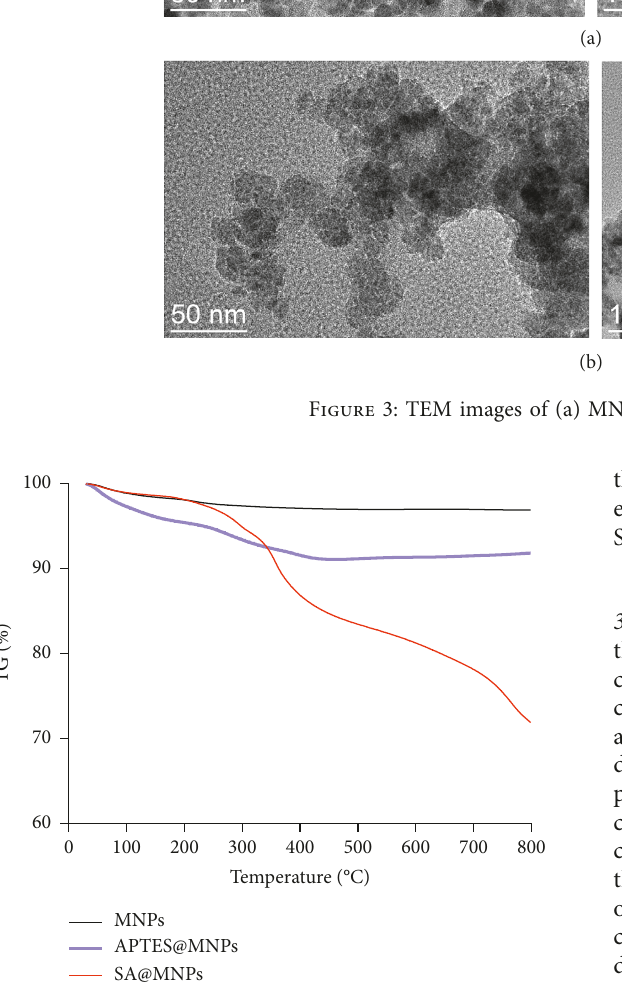
Figure 4: TGA thermograms of MNPs, APTES@MNPs, and SA@